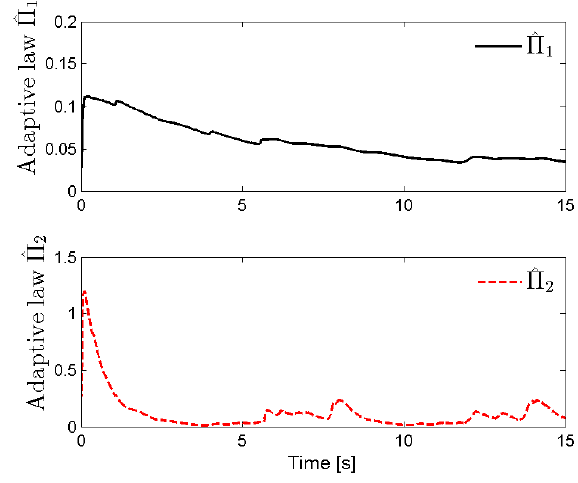
Π ( 1,2 i = ). Figure 13. Trajectories of adaptive law ˆ Π i ( i = i